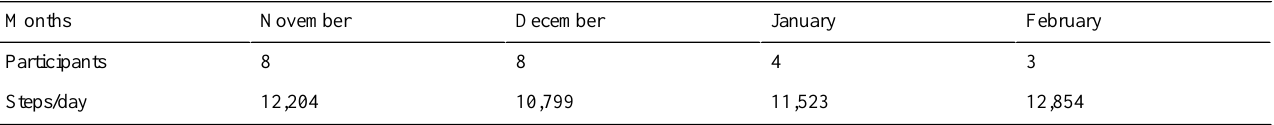
Table 1. Average number of steps per day. FebruaryJanuaryDecemberNovemberMonths 3488Participants